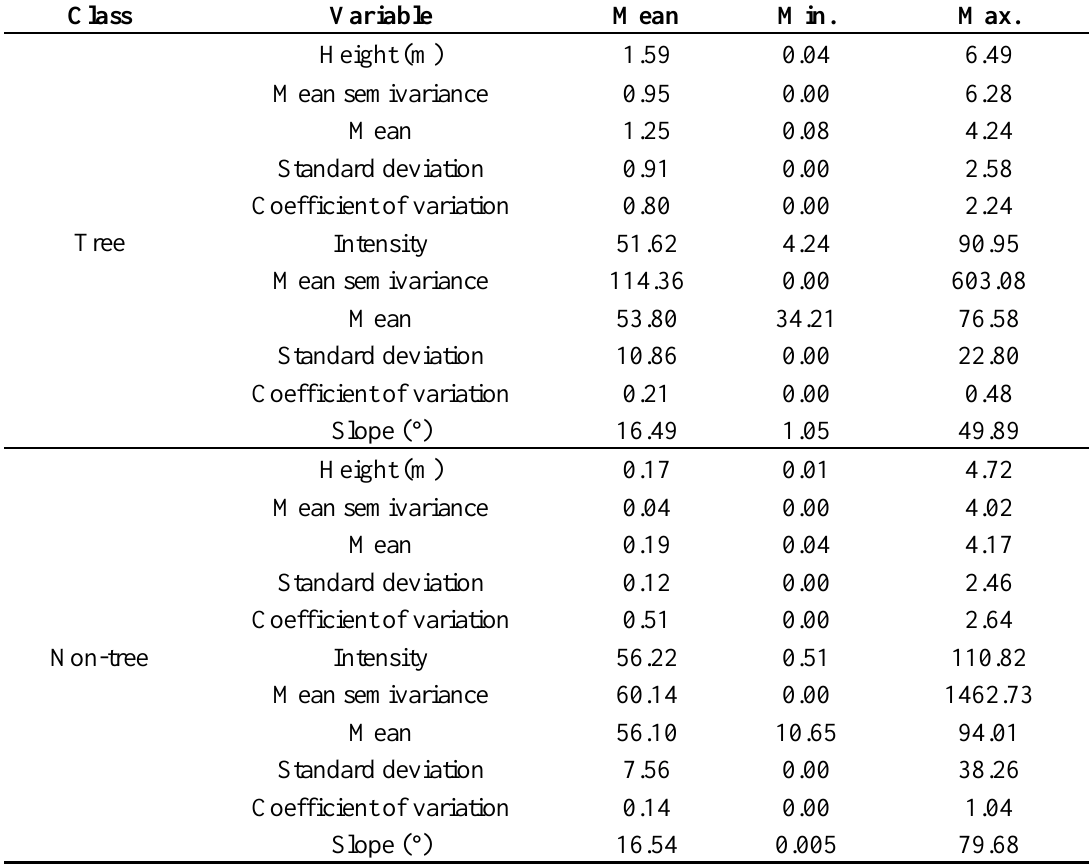
Table 4. Summary of the discriminator